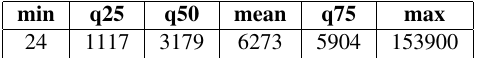
Table 1: Quantiles of the building volumes [ m 3 ] within the test area in Munich.